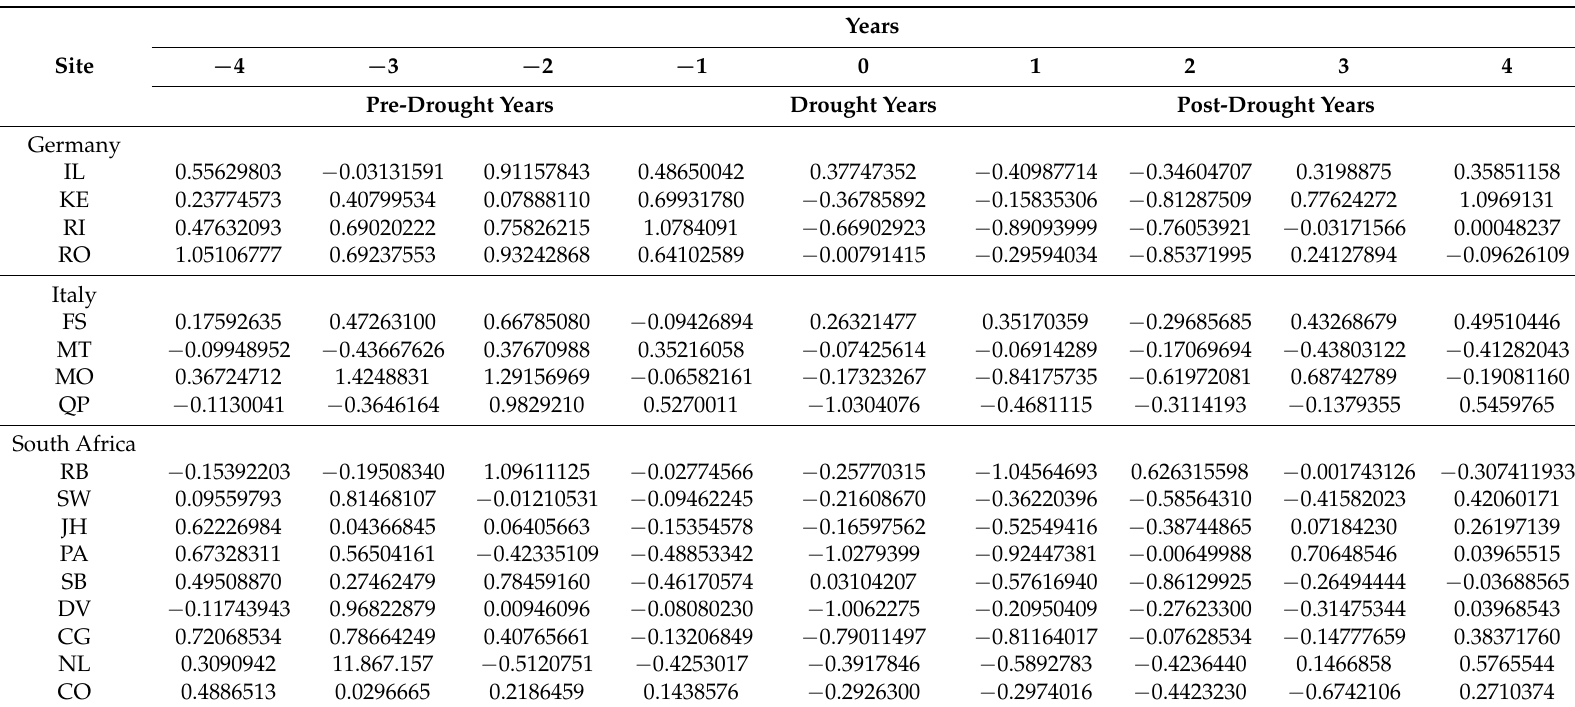
Table A4. Superposed epoch analysis for each region within the experiments Germany, Italy, and South Africa, respectively. Mean RWI departures are listed for the pre-drought years ( − 4 to − 1), the drought years itself (0) and the post drought years (1 to